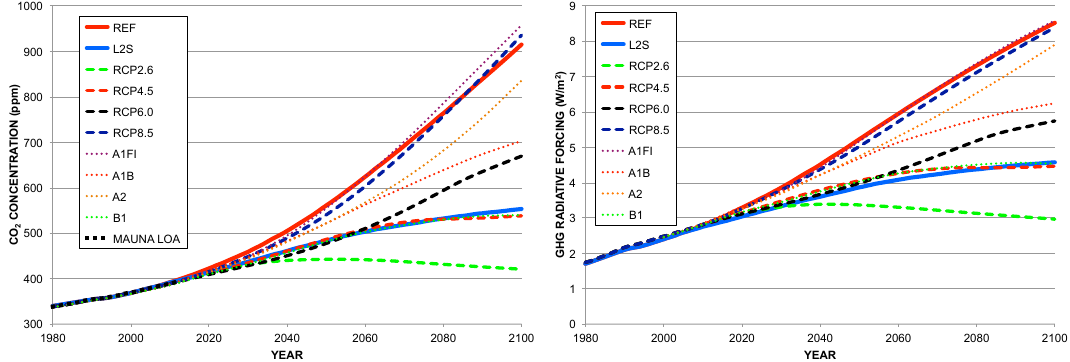
Fig. 2. Global mean (left) CO 2 concentrations (ppm) and (right) greenhouse gases radiative forcing (Wm − 2 ) for the REF and L2S scenarios, the A1FI, A1B, A2 and B1 SRES scenarios and the RCP2.6, RCP4.5, RCP6.0 and RCP8.5 scenarios. Observed CO 2 concentrations at Mauna Loa are also